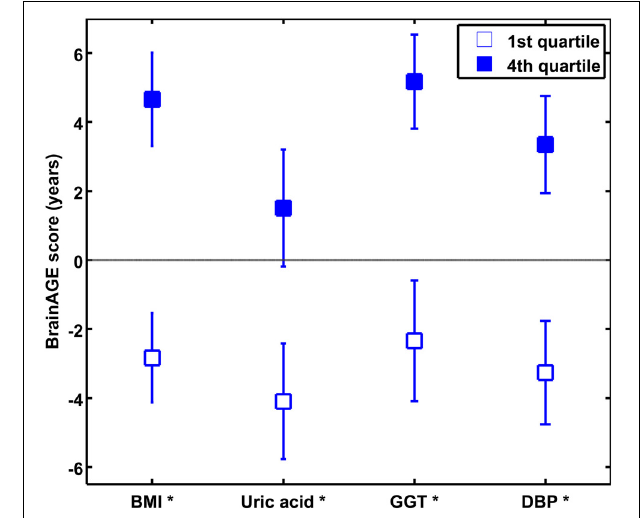
FIGURE 2 | PLS regression model of the male sample. When modeling the relationships between BrainAGE and health parameters, the PLS regression model explained 39% of variance in BrainAGE ( p < 0 . 001): BMI, uric acid, GGT, and DBP are the most significant physiological and clinical chemistry parameters as they added most to the explained variance in BrainAGE (top chart) and also showed the highest variable weights, i.e., the highest impact in the regression model (bottom chart).